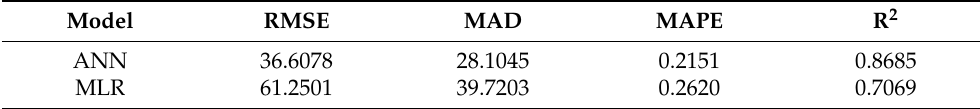
Table 4. Prediction performance of the fitted models in the testing stage. Figure 6. Predicted values of the fitted models with actual data points.